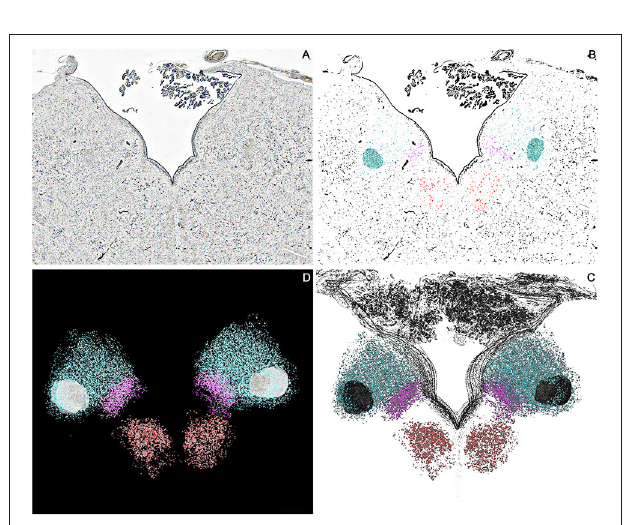
FIGURE 4 | Axial sections of one brainstem specimen at the level of the Ala Cinerea (Tissue sections (B,C) according to Figure 1 ). (A) Nissl Stained section, 1.25x Magnification. (B) Thresholded photomicrograph with color-labeled Regions of Interest (ROIs) for the Hypoglossal Nucleus (Red), Dorsal Motor Nucleus of the Vagus (Violet), Solitary Tract and Solitary Tract Nucleus (Blue). (C) 3D reconstruction of the neuronal profiles of the Hypoglossal Nucleus (Red), Dorsal Motor Nucleus of the Vagus (Violet), Solitary Tract, and Solitary Tract Nucleus (Blue) at the level of the Ala Cinerea [Tissue sections (B,C) ]. (D) 3D Reconstruction of the Rhomboid Fossa along with the neuronal populations of the nuclei of the brainstem